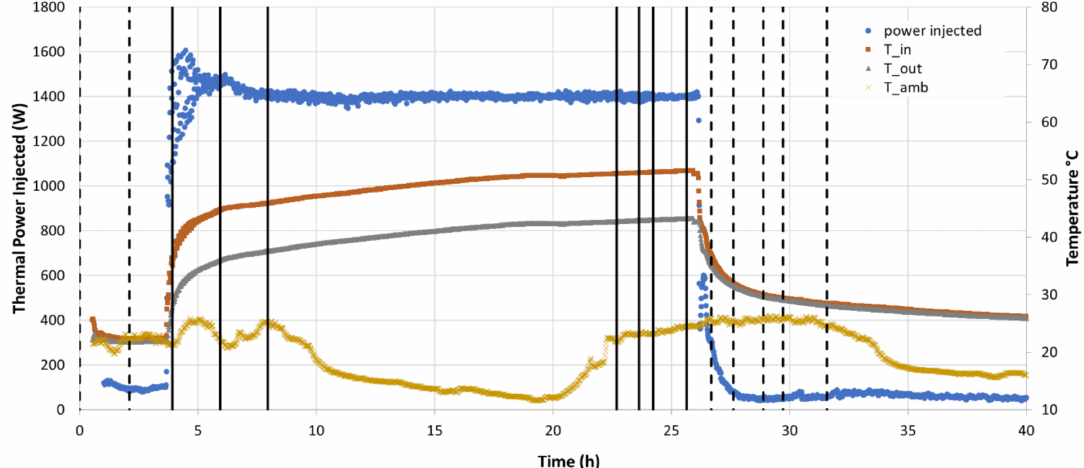
Figure 5. The applied heat load (16–17 May 2018). The inlet temperature (T_in), outlet temperature (T_out), and ambient temperature (T_amb) are also displayed. The vertical lines represent the times when the GEOsniff measurements were made (first set of dashed lines: undisturbed 1 + 2; solid lines: impact 1–7; and second set of dashed lines: down